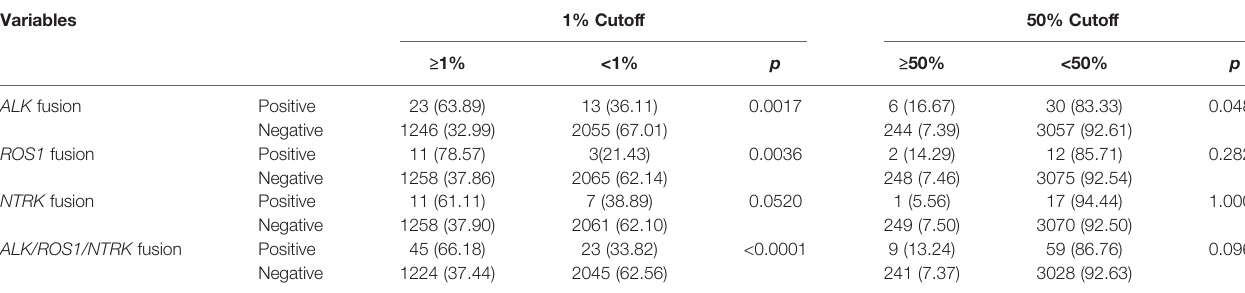
TABLE 2 | Summary of PD-L1 expression in patients with ALK , ROS1 , and NTRK fusions, n (%).